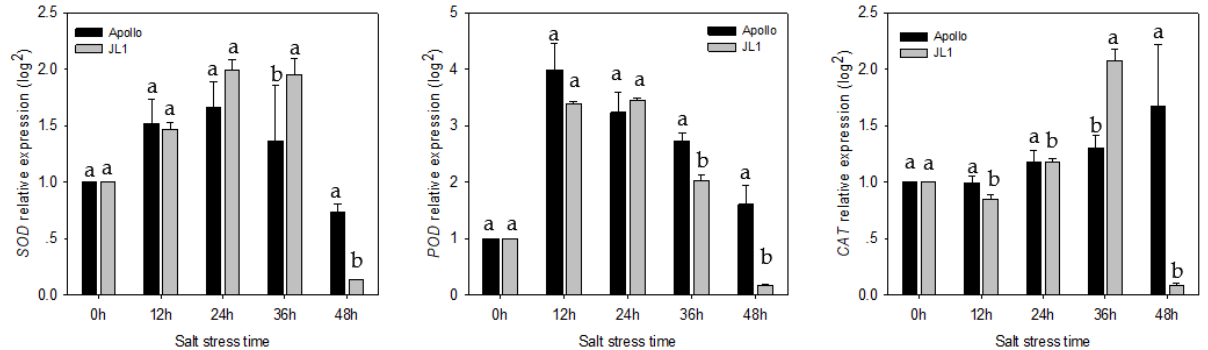
Figure 6. The SOD , POD , CAT gene relative expression in two cultivars under salt stress. Different lowercase letters in the bar graph indicate significantly different of gene relative expression between the two cultivars at p <0.05.